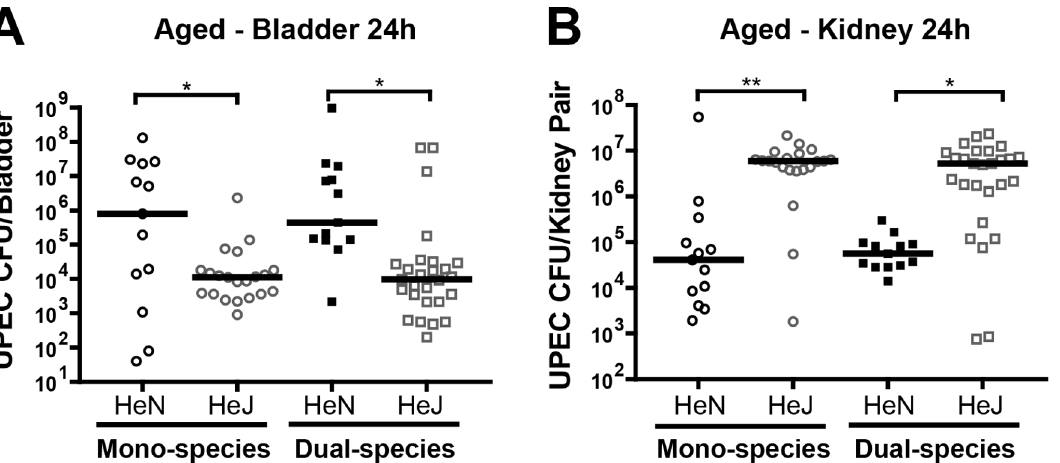
Figure 3. Multiparity-associated augmentation of UPEC cystitis is blunted in C3H/HeJ mice. UPEC CFU in bladders ( A ) and kidneys ( B ) were determined 24 hours after mono- or dual-species infection in 7–11 month old multiparous C3H/HeN and C3H/HeJ mice. N=2–4, at least 5 mice per experiment. The horizontal bar represents the median value for each group of mice. Statistical significance was determined by the Kruskal-Wallis test with Dunn’s post-test for multiple comparisons. * P , 0.05, ** P , 0.005.